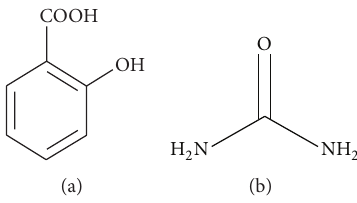
Figure 1: Chemical structure of (a) salicylic acid and (b) urea [7].